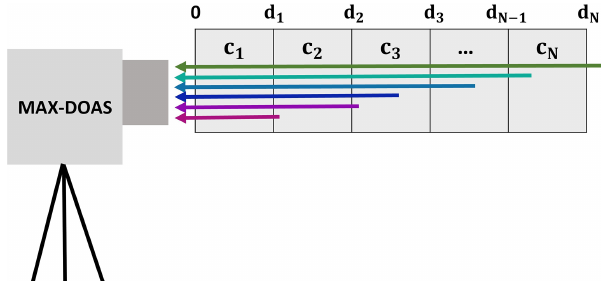
Figure 10. Schematic representation of the six different L NO one horizontal line for each wavelength) used in the new horizon- tal distribution inversion approach. The length of each line shows the sensitivity of each wavelength as a function of the horizontal distance. The shortest line represents the smallest wavelength.